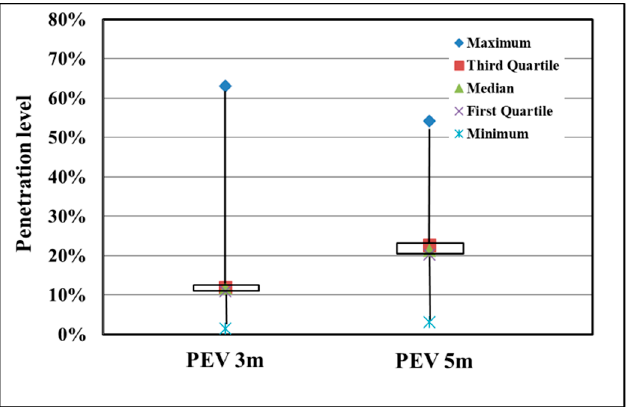
Figure 8. Box plot analysis for PEV portion per 154 kV substation in each scenario.